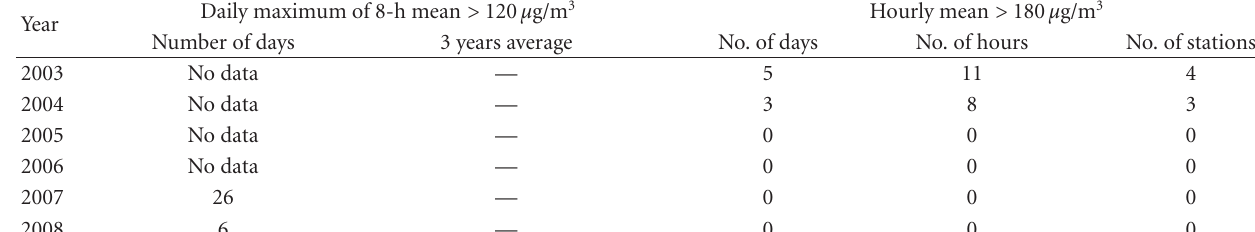
Table 1: Summary of exceedances of the ozone thresholds stablished by the Ambient Air Quality and Cleaner Air for Europe Directive [39] in five stations at the Northwestern Iberian Peninsula during the period 2003–2008. Source [40].